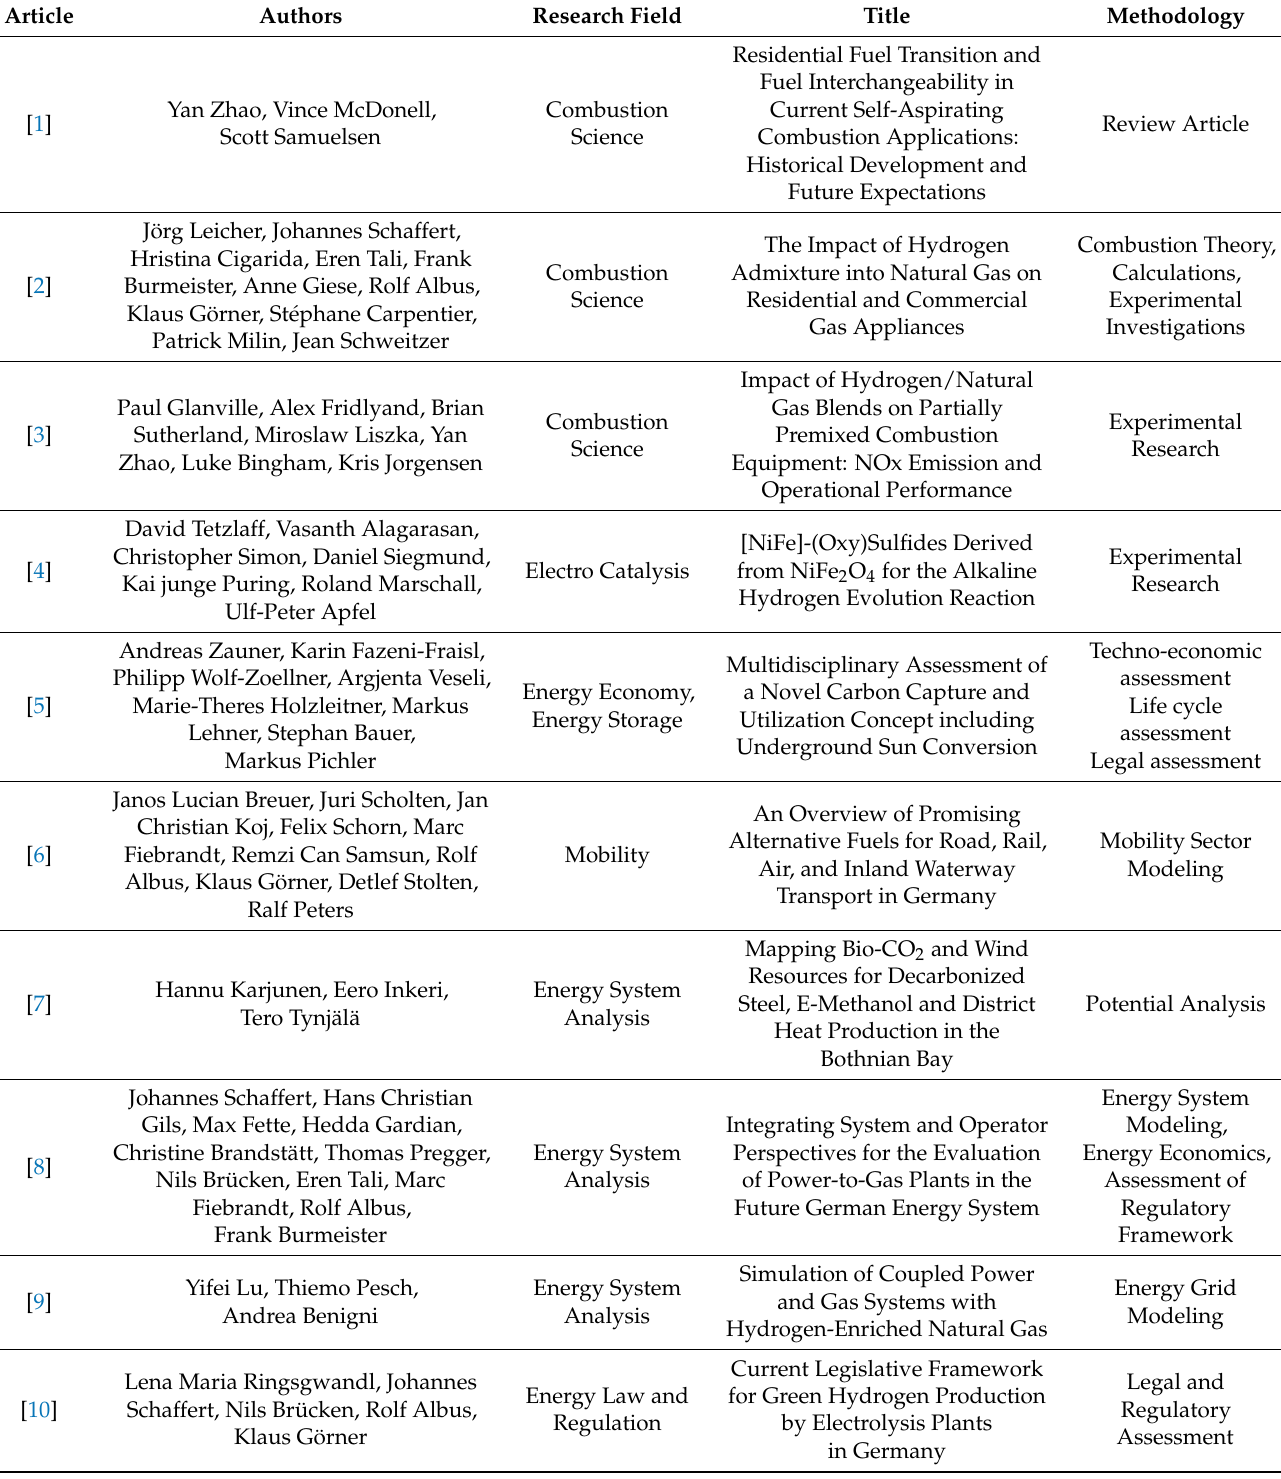
Table 1. Summary of the research fields, titles, and methodologies of the Special Issue